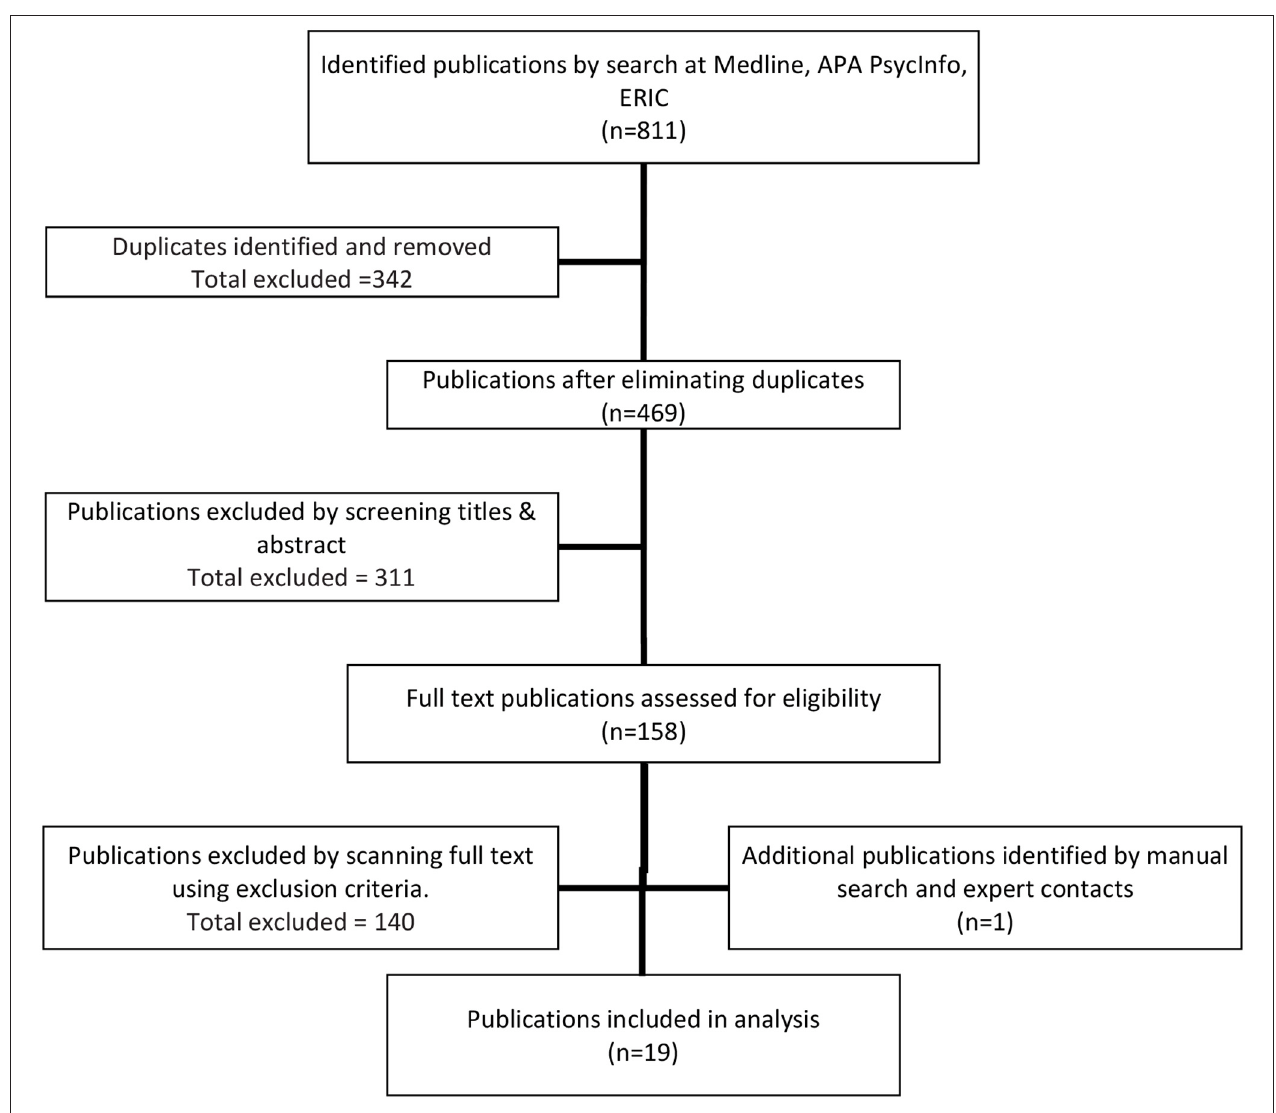
FIGURE 1 | Flow diagram of study